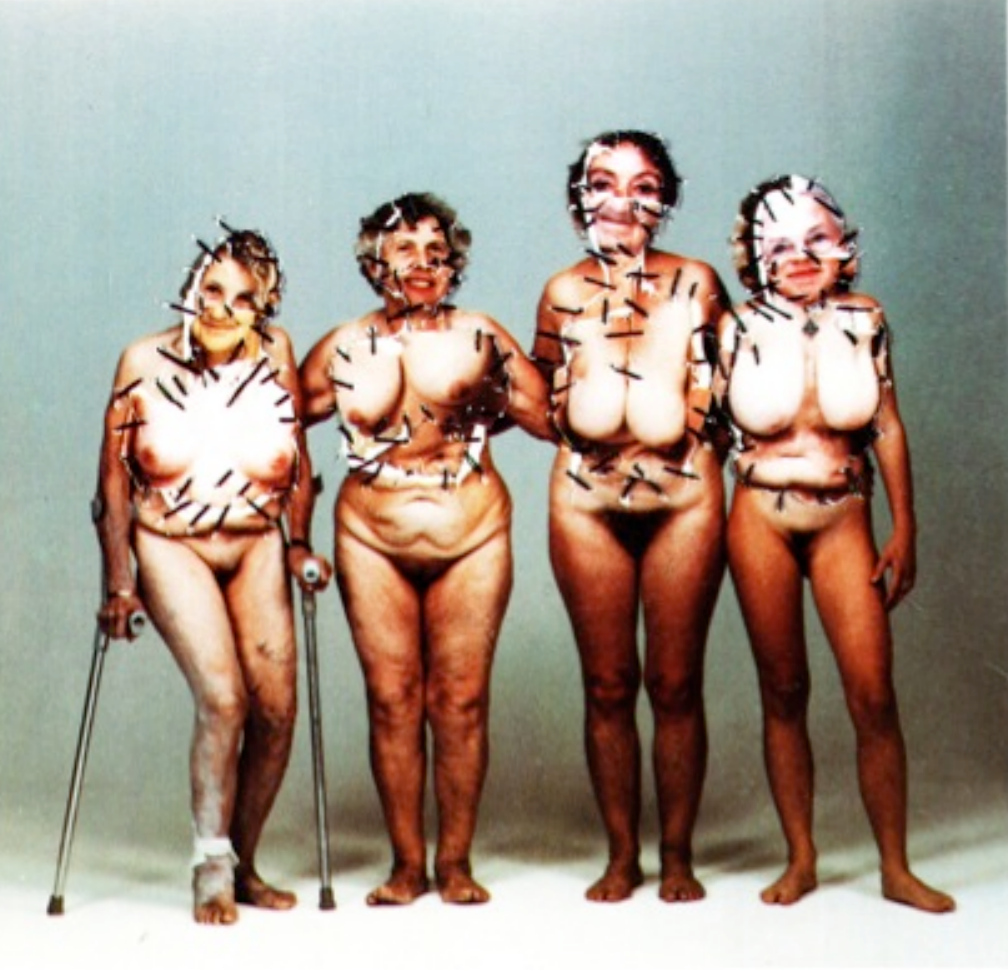
Heather Hanna, A Visual Essay: Interventions and Manipulations in the Maternal Studies in the Maternal, 4(1), 2012,